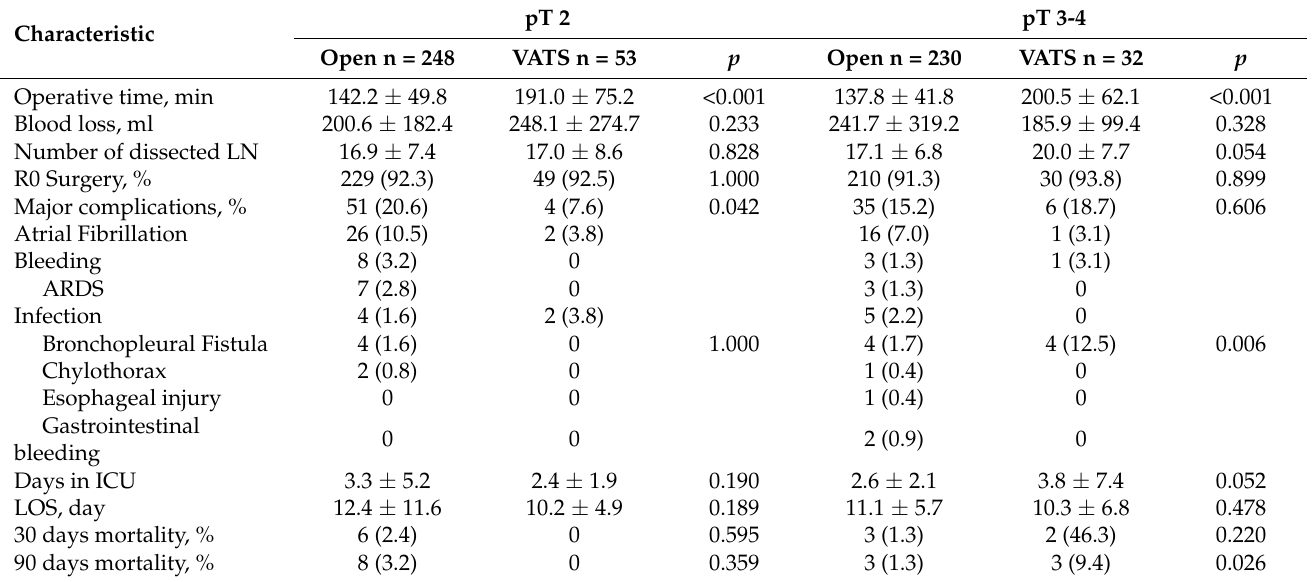
Table 4. Clinical characteristics and perioperative outcomes between Open and VATS pneumonec- tomy for pT 2 tumors. and pT 3-4